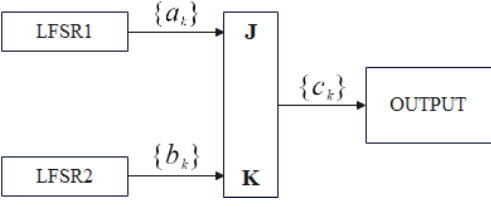
Figure 2. J-K flip-flop, which use two LFSRs and one